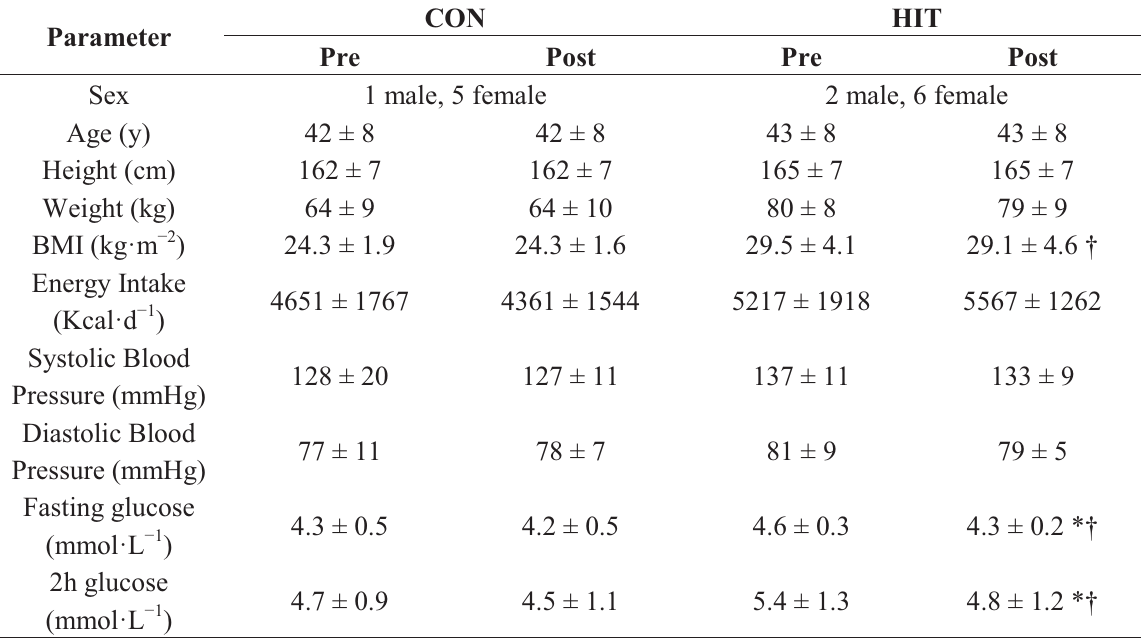
Table 1. Participant characteristics; * p < 0.05 pre versus post, however, there was no significant difference in the magnitude of the change between groups; † d > 0.7 effect size of magnitude of change between the